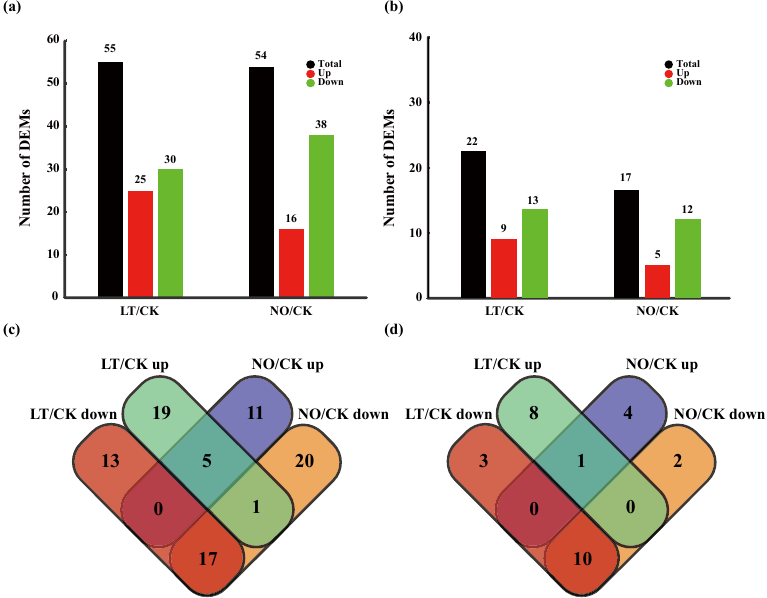
Figure 1. Summary of differentially expressed microRNAs (DEMs). Numbers of known DEMs ( a ) and novel DEMs ( b ) between LT (low temperature) and CK (control), and between NO (nitric oxide) and CK; Venn diagrams of known DEMs ( c ) and novel DEMs ( d ) between LT and CK, and between NO and CK. ‘LT/CK up’ and ‘LT/CK up’ represent the up-regulated and down-regulated DEMs between LT and CK, and ‘NO/CK up’ and ‘NO/CK up’ represent the up-regulated and down-regulated DEMs between NO and CK, respectively. The numbers in each cell indicate the number of miRNAs regulated by LT or NO alone, or co-regulated by LT and